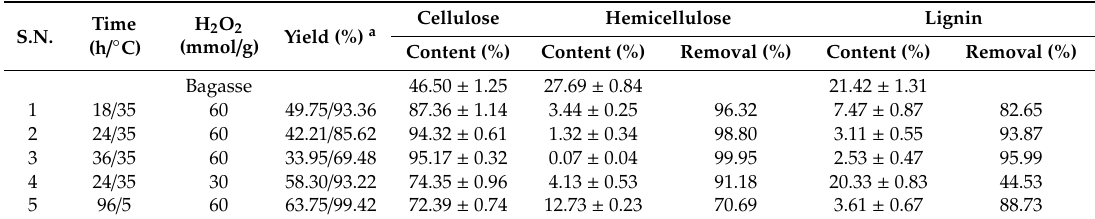
Table 1. Bagasse was treated with time, temperature, and dosage of H 2 O 2 , as well as the yield, chemical component, and removal